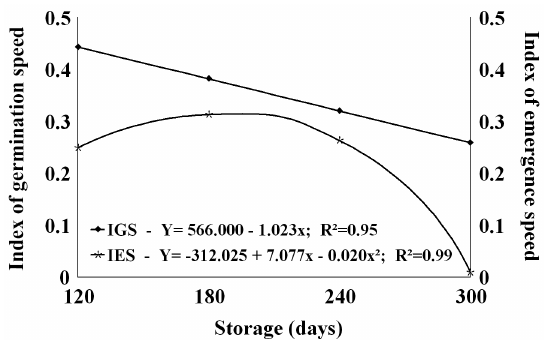
Fig. 4- Index of germination speed and index of emergence speed in Croton urucurana seeds incubated in BOD at 20/30°C in greenhouse.